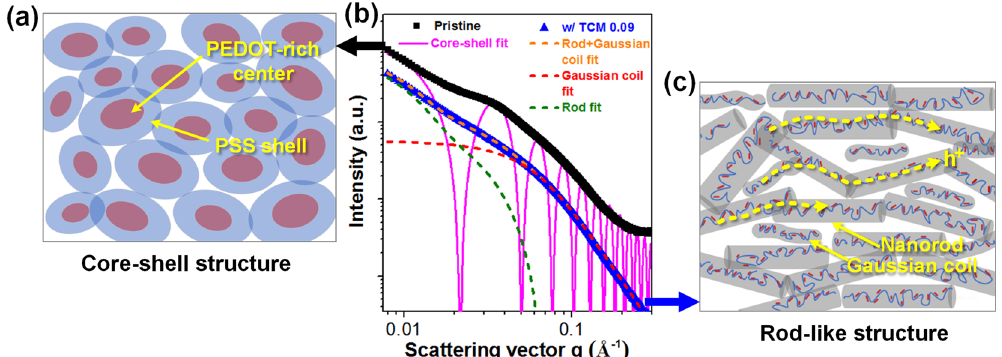
Fig. 2 Solution supramolecular assembly of PEDOT:PSS solution. a , c A microphase-segregated core (PEDOT)-shell (PSS) structure ( a ) and a rod-like microstructure ( c ) consisting of rigid rods and associated soft Gaussian coils, corresponding to PEDOT and PSS molecules, respectively, were used to fi t the SAXS data of PEDOT:PSS hybrid solutions ( b ). The conductive pathway is schematically illustrated in ( c ) with dashed